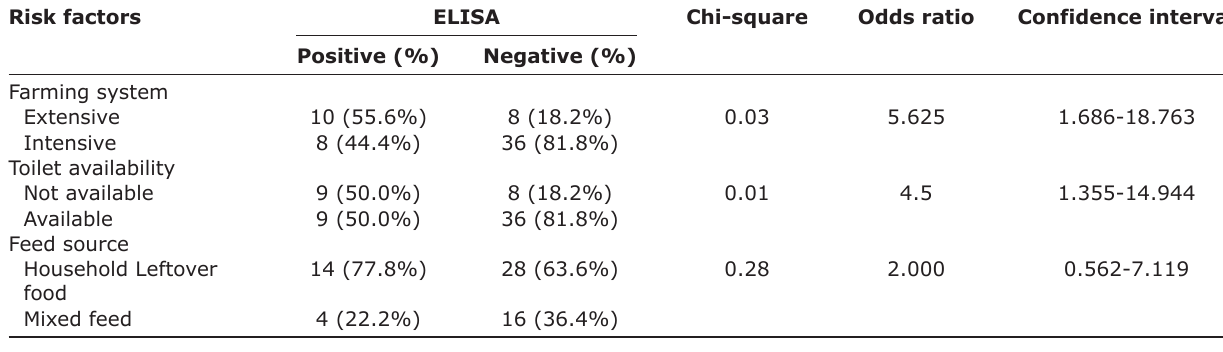
Table-1: ELISA results for cysticercosis seroprevalence and risk factors. Risk